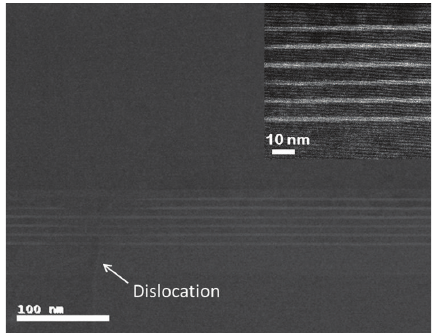
Figure 2: Cross-sectional HRTEM image of the InGaN/GaN MQW region in the LED. The bright rows are the InGaN layers. Some MQWs are not able to be observed at the position of the TD. The inset shows a large magnification of the MQWs; there are not any side-wall wells, stacking faults at the InGaN/GaN interfaces, or so- called InGaN quantum dots observed in the MQWs region.